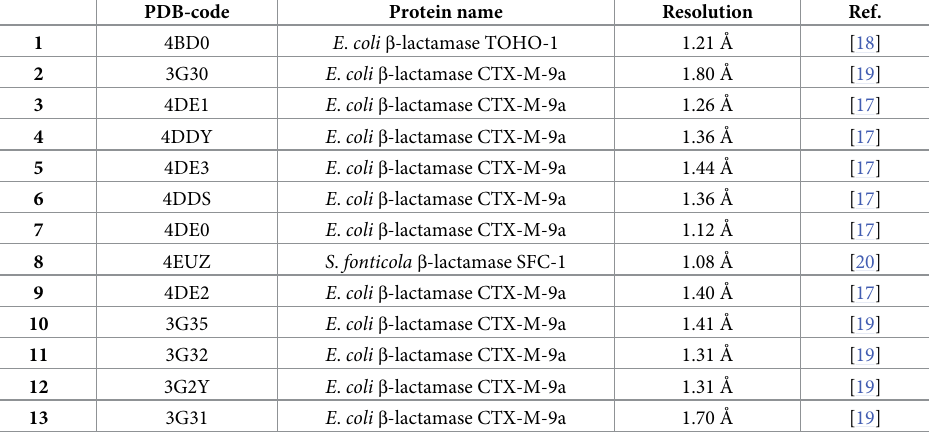
Table 1. Result of PoSSuM Search K for similar binding sites. Structures with binding sites similar with structure 3RXW in complex with a non-covalent ligand were reported.